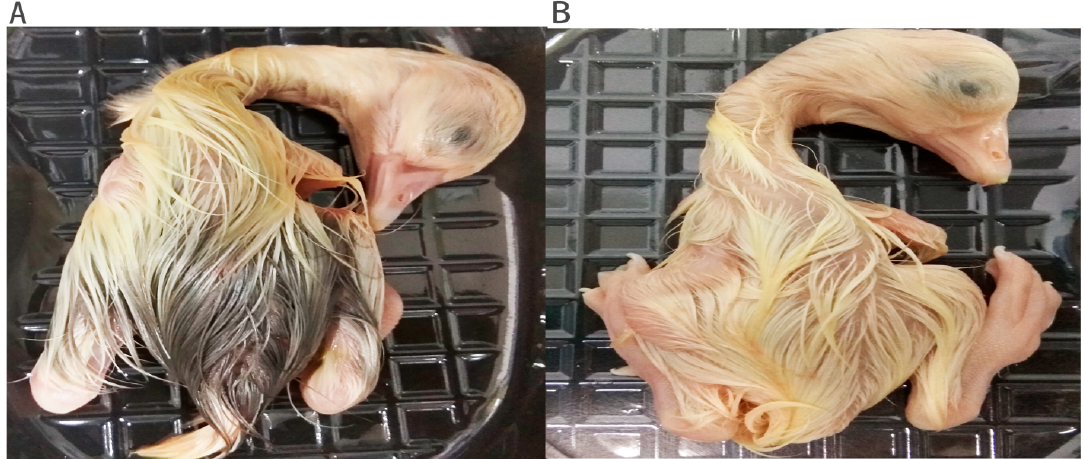
Figure 8. The Anser anser and Anser cygnoides fluffy embryonic downy pigmentation . ( A ) Anser anser ; ( B ) Anser cygnoides .